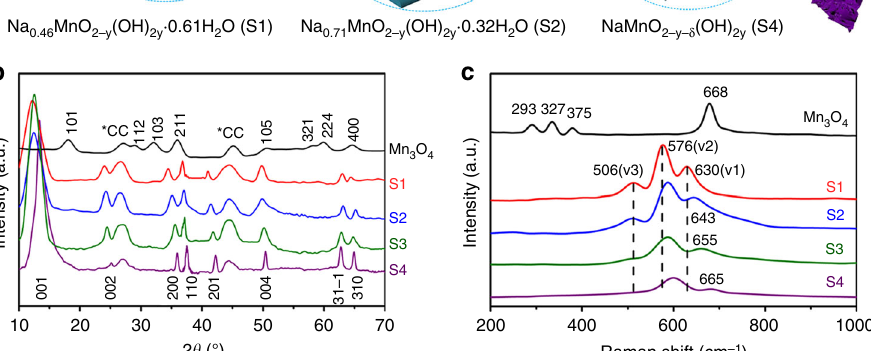
Table 1 Comparison of electrochemical performances for different layered Na x MO 2 electrodes (M, transition metal) Cathode electrodes (loading mass/mg cm − 2 ) Potential range (V) Rate performance Capacity retention Reference